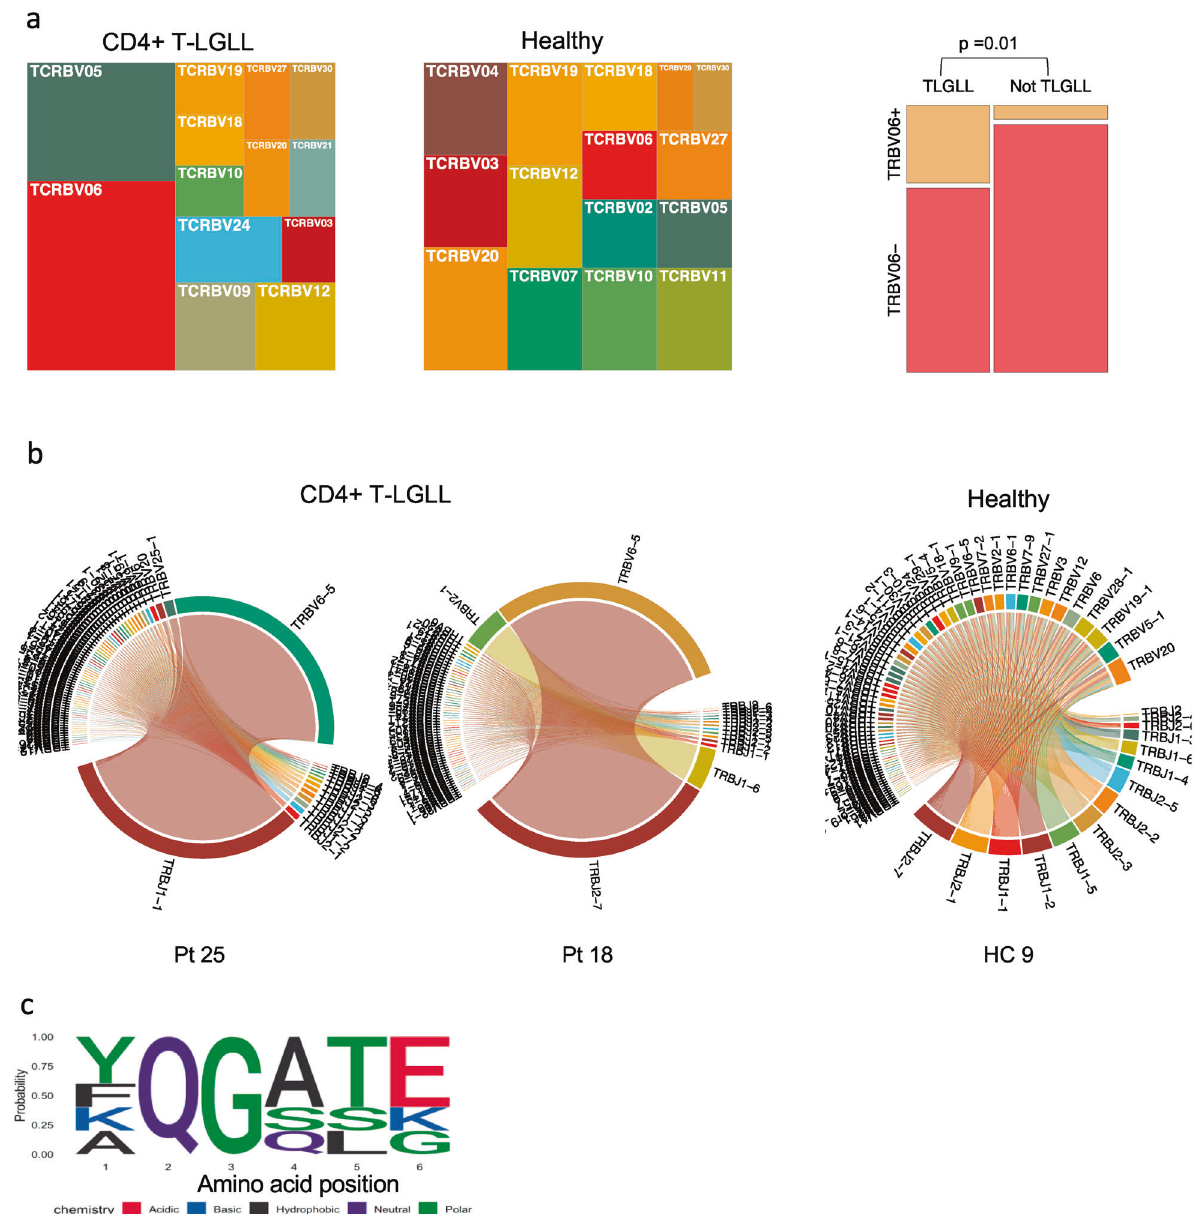
Fig. 6 Structural similarities in CD4 + T-LGLL clones. a Comparison of V gene family usage between CD4 + T-LGLL clones and healthy controls. 20% of the leukemic clones express the TRBV06 gene. b Circos plots showing skewed V gene usage in two representative CD4 + T-LGLL as compared to one representative healthy sample. c Logo plot showing the non-conservative middle part of TCRs CDR3, which is usually within 5 Å of the antigen. The “ QG ” motif that was found in the middle CDR3 in multiple CD4 + T-LGLL clones is shown in CDR3s that are 13 amino acids